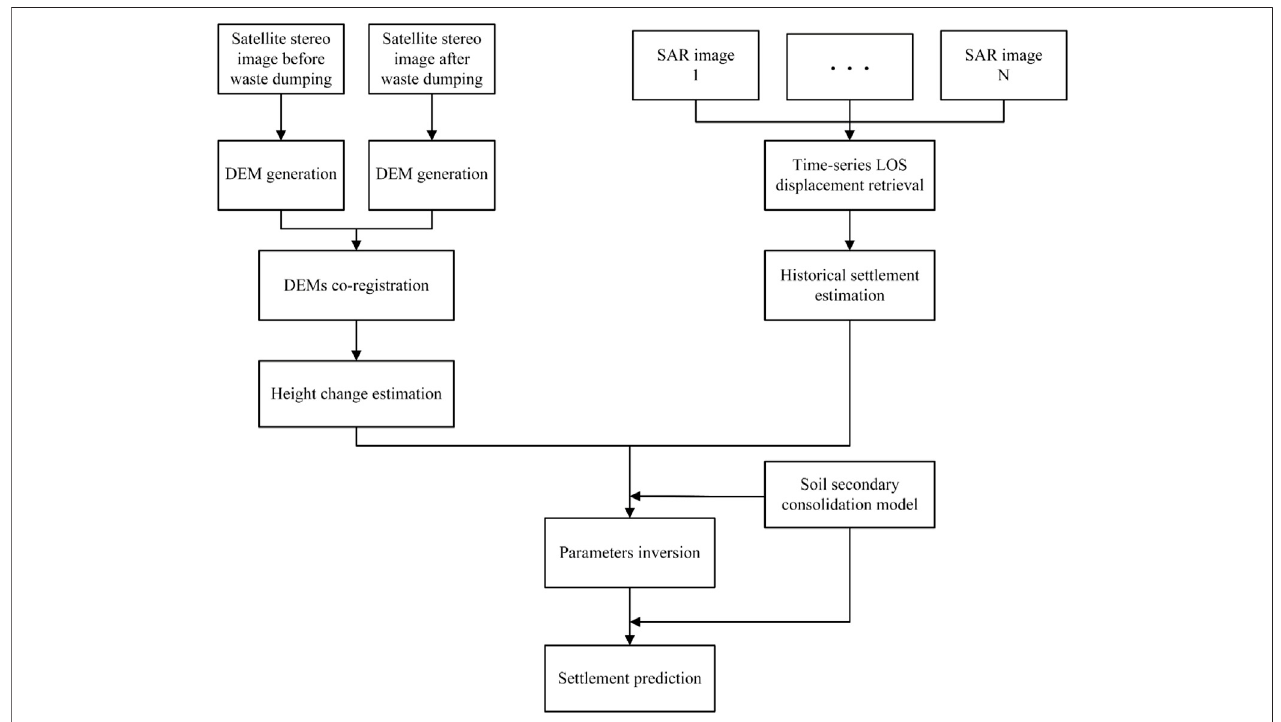
FIGURE 2 | The work fl ow of the presented method.